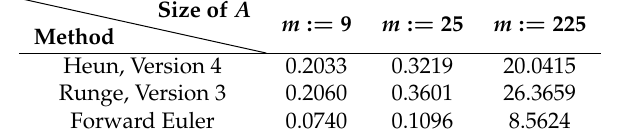
Table 3. Results of a comparison between the runtimes (in seconds) of the Heun method, Version 4, the Runge method, Version 3, and the Euler method.